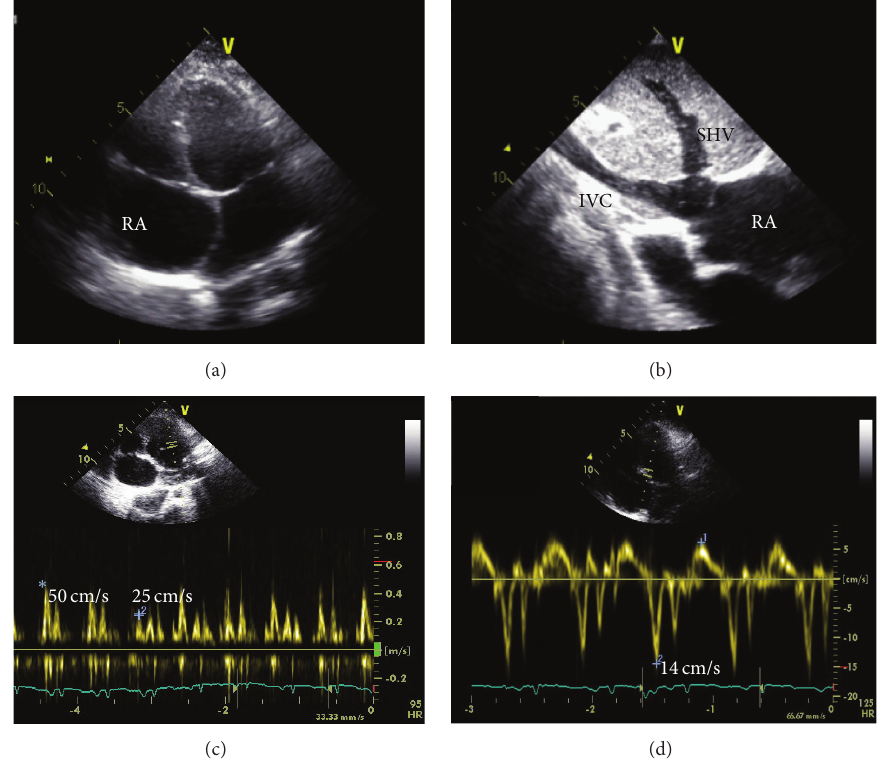
Figure 3: (a) Apical 4-chamber view with dilated right atria (RA), left deviated atrial septum; (b) subcostal view of dilated inferior vena cava (IVC) and suprahepatic veins (SHV); (c) significant (50%) transmitral flow variation with breathing, increasing during expiration ( ∗ ) and decreasing during inspiration (+); (d) high protodiastolic mitral annulus velocity (septal 14 cm/s, higher than lateral).